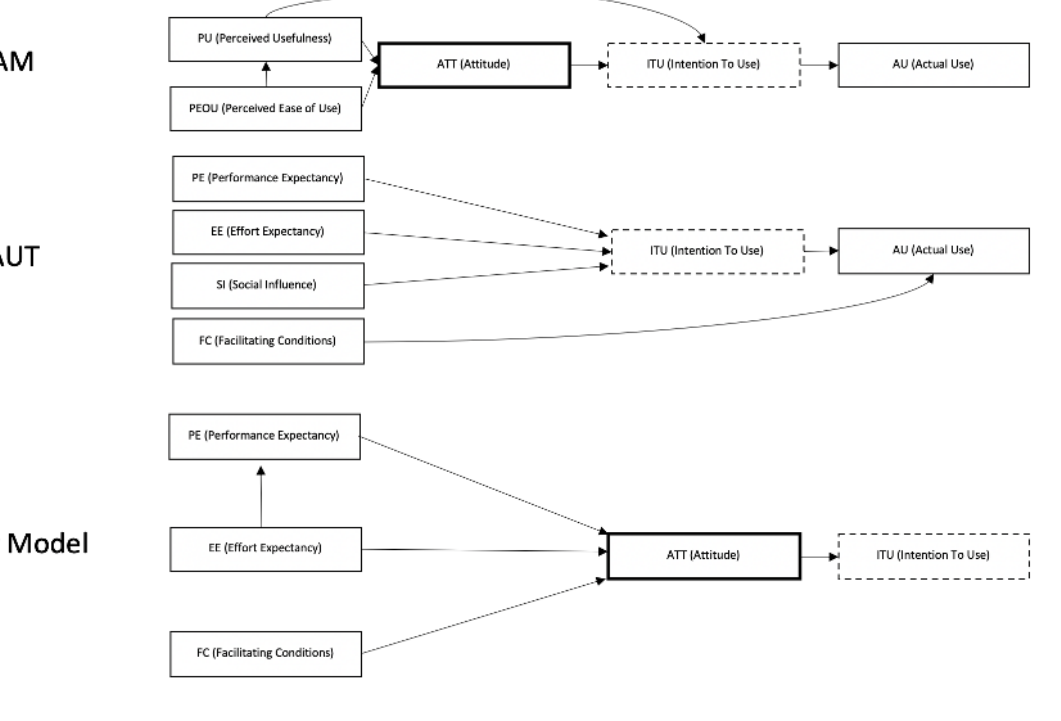
Figure 4. The analytical model used in this study, modified from the technology acceptance model (TAM) and the unified theory of acceptance and use of technology